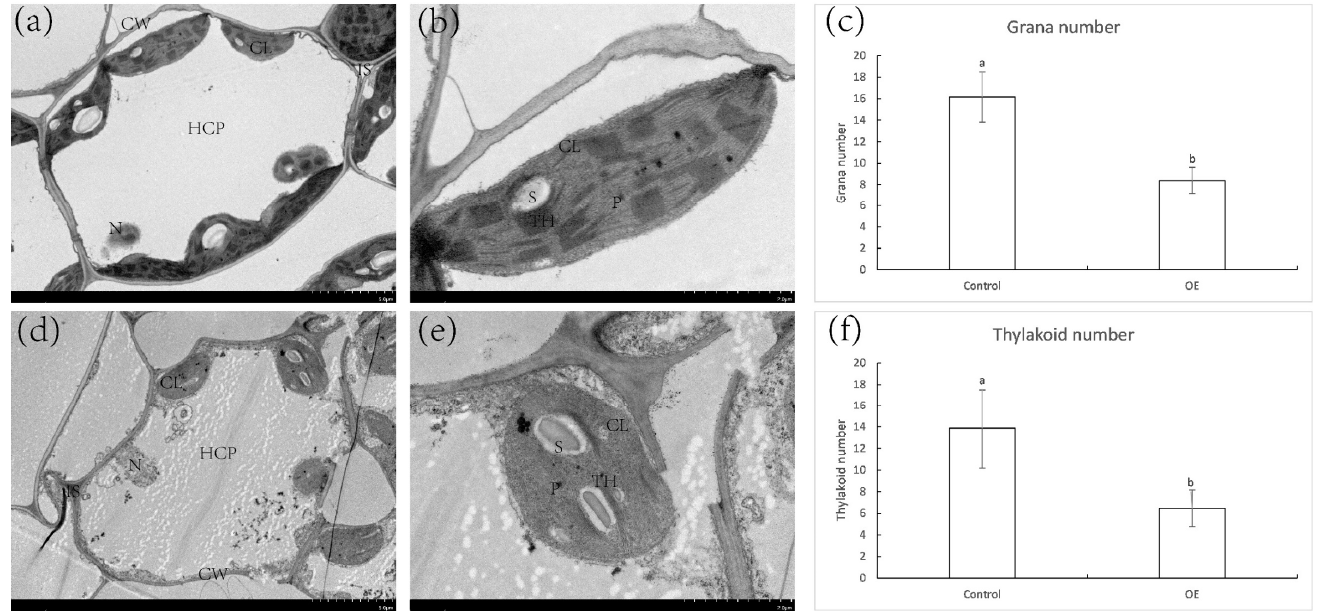
Figure 10. Changes in cell and chloroplast structure in leaves of control and OE. ( a , b ) Transmission electron microscopy analysis of cells and chloroplast in control leaves; ( d , e ) transmission electron microscopy analysis of cells and chloroplast in OE leaves. ( c , f ) Grana number and thylakoid number of chloroplasts in control and OE cells. Different letters above the columns indicate significant differences ( p < 0.05, n = 20). a , c , Scale bar = 5 μ m; d , e , scale bar = 2 μ m. CL, chloroplast; CW, cell wall; HCP, huge celled parenchyma; IS, intercellular space; N, nucleus; P, plastglobulus; S, starch granule; TH, thylakoid.